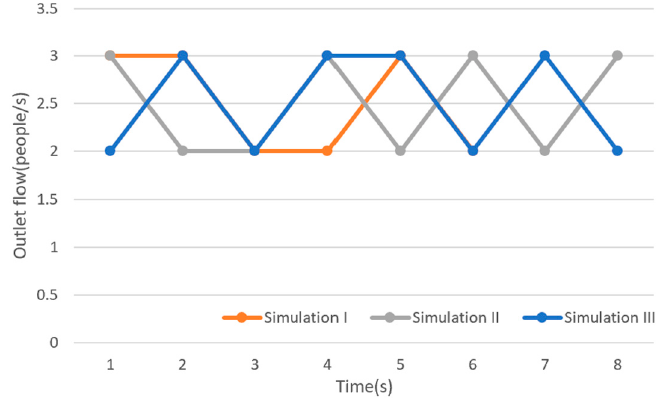
Figure 31. Line chart of the outlet flow simulation.